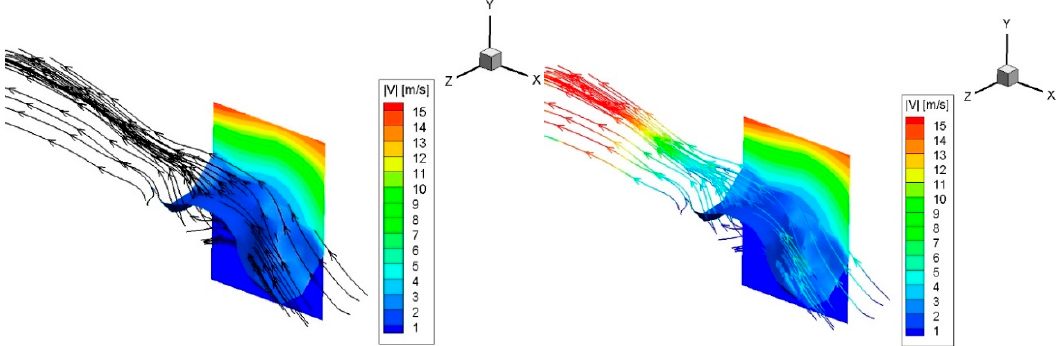
Figure 13. Iso-surfaces and streamlines at two display formats. Reproduced from Stolt et al. [30].